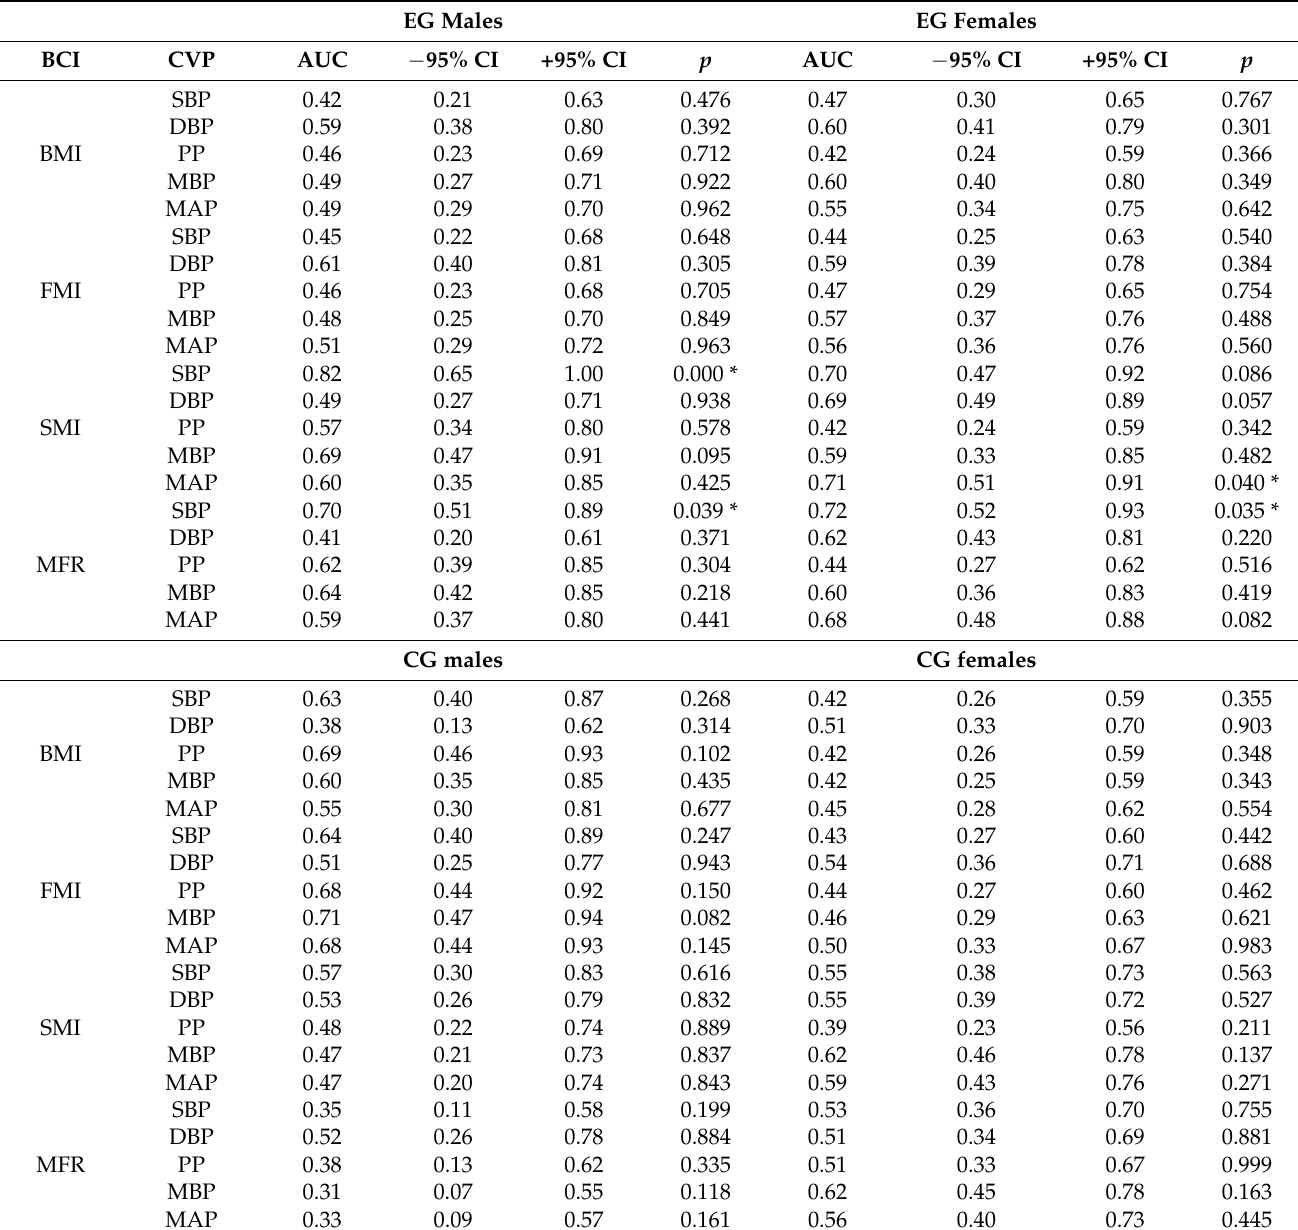
Table 2. The area under the curve (AUC) and respective cut-off points across all body composition measurements and cardiovascular parameters in experimental (EG) and control groups